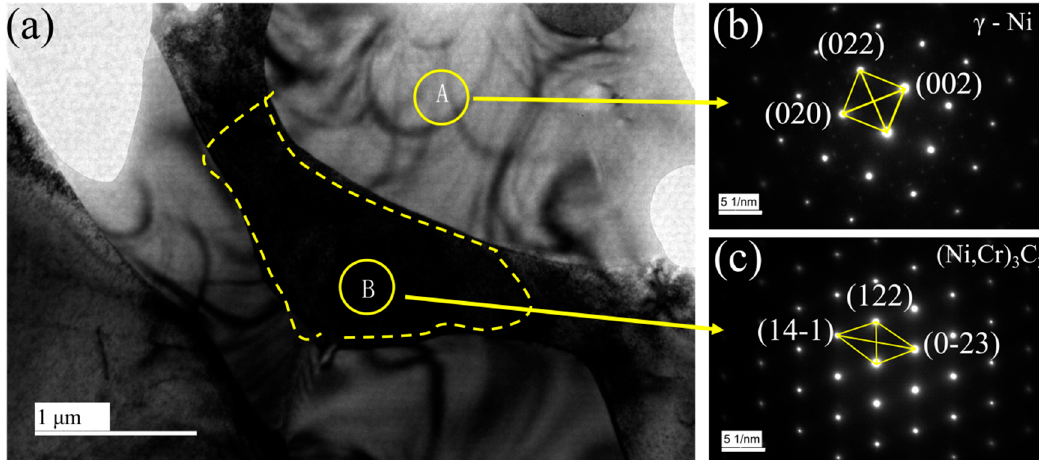
Figure 10. TEM image and SAED patterns of the coating. ( a ) TEM image, ( b ) SAED patterns of region A, ( c ) SAED patterns of region B.